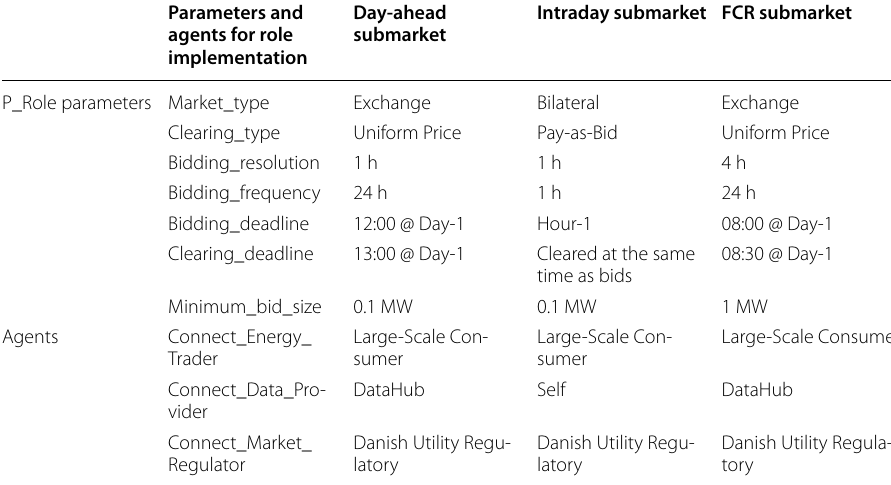
Table 4 Market Operator role implementation for different submarkets (data from Fatras et al. 2022b; Energinet Regulation A 2007))